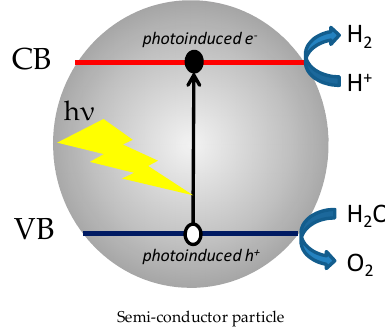
Figure 7. Principle of water splitting using semiconductor photocatalysts from Kudo et al. [54].